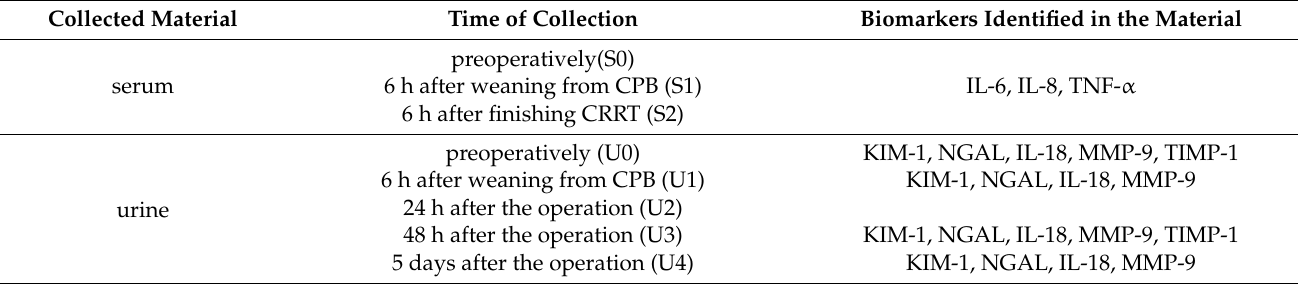
Table 2. Types of material collected from the patients and selected biomarkers of renal injury identified in them at the designated time points. Collected